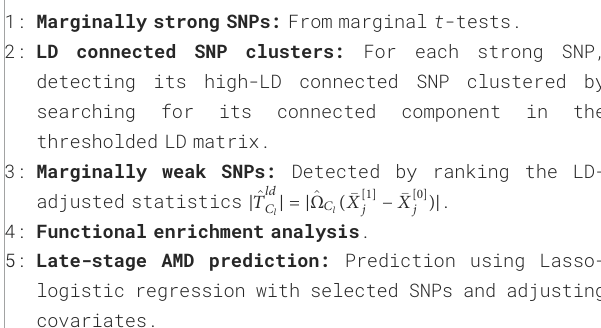
Algorithm 1 Procedure for detecting strong and weak signals